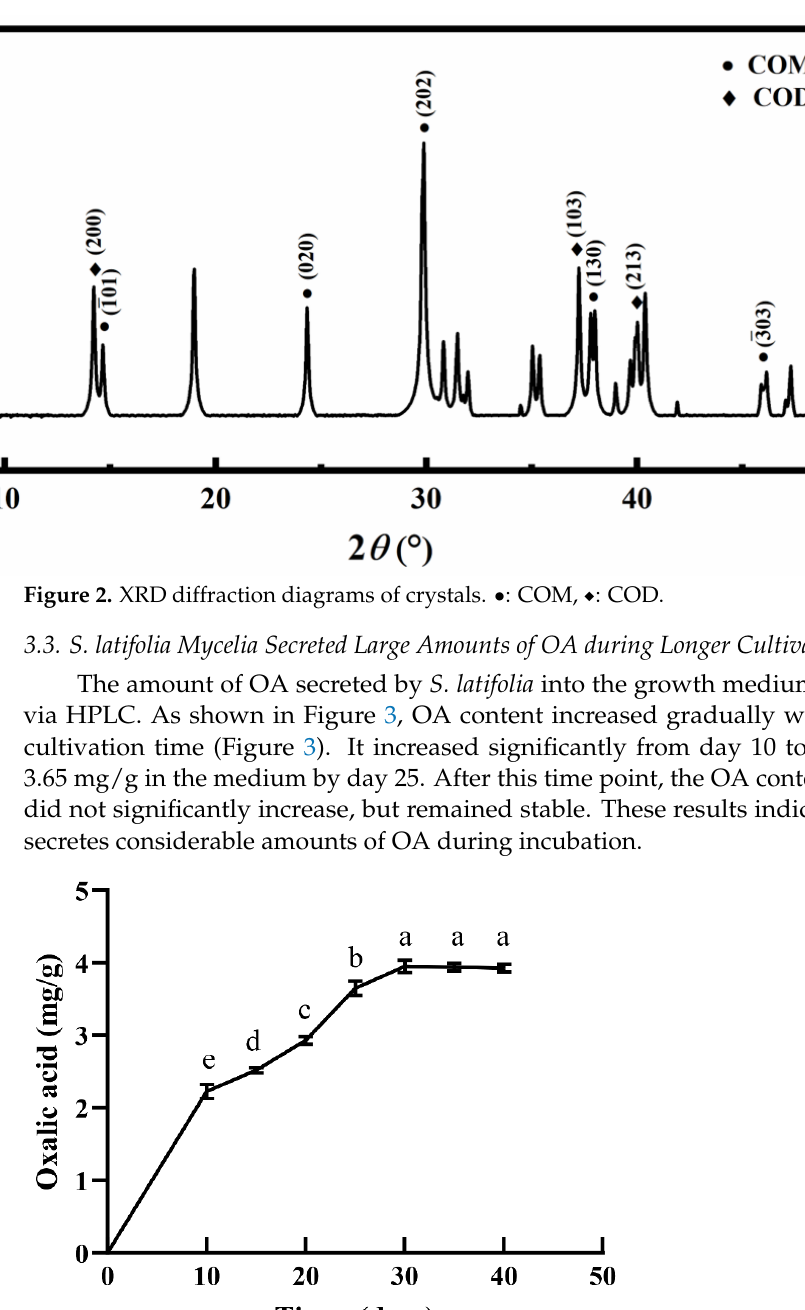
Figure 3. OA content in the growth medium at different time points during cultivation. Data were analyzed with Duncan’s ANOVA test. Error bars represent the standard deviation of three replicates. Different letters indicate significant differences between the lines ( p ≤ 0.05).